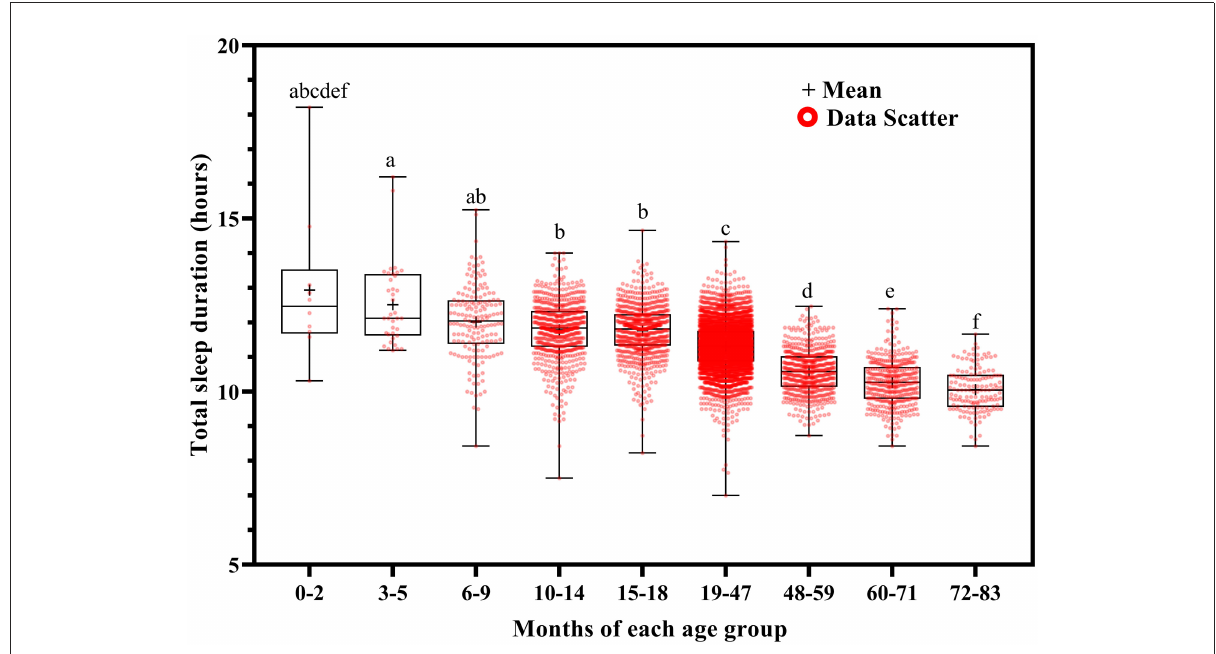
FIGURE6 Results of the one-way ANOVA for total sleep duration stratified by age.